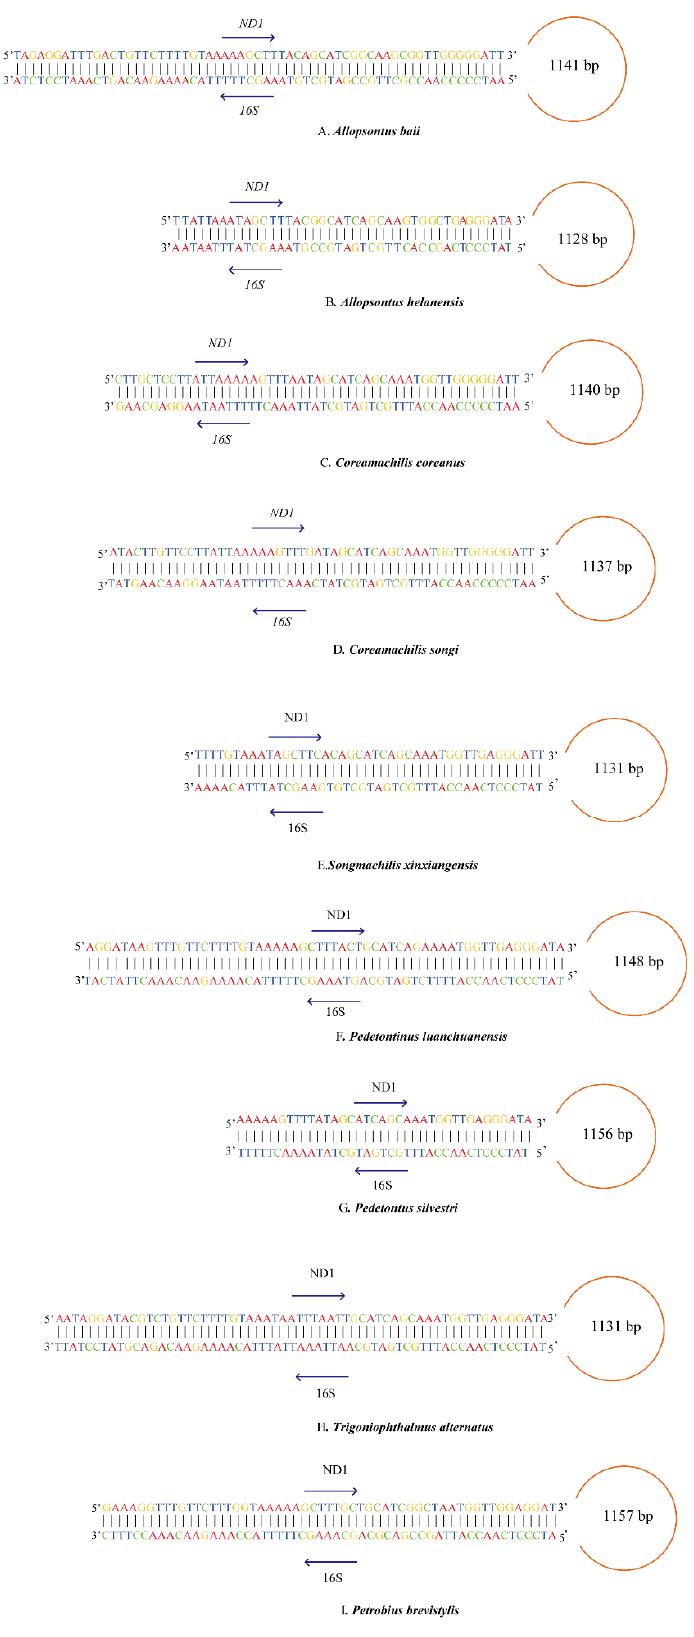
Figure 3. Inferred hairpin structures of nine mitogenomes. The circle means the length between the ND1 gene and 16S RNA gene.